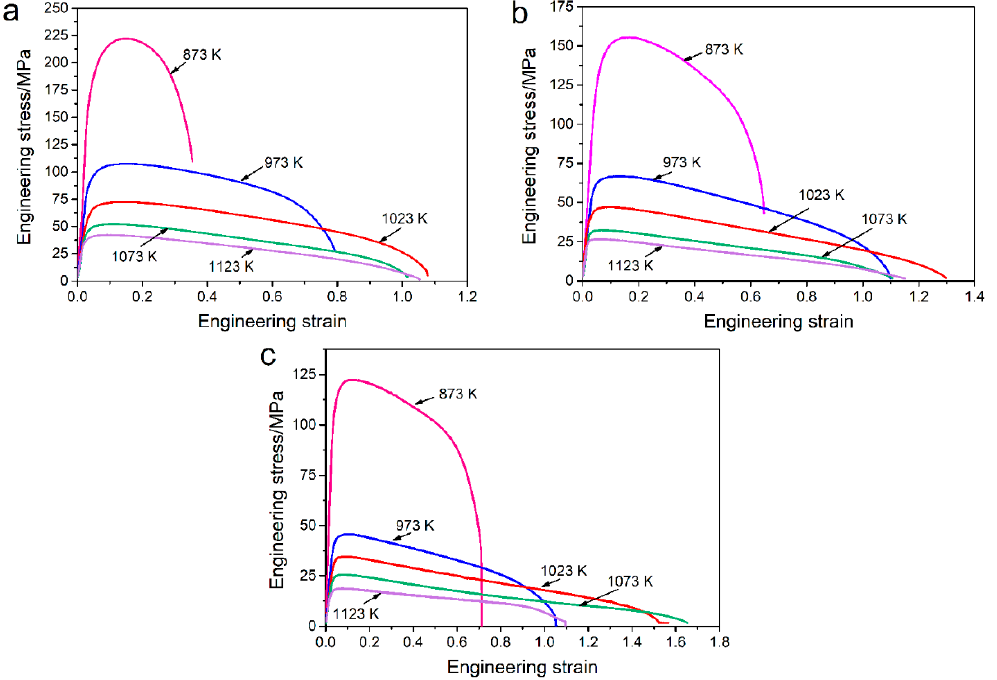
Figure 2. Tensile engineering stress–strain curves of the 0Cr18AlSi steel tested at various temperatures with strain rates of ( a ) 1.7 × 10 − 2 s − 1 ; ( b ) 1.7 × 10 − 3 s − 1 ; and ( c ) 1.7 × 10 − 4 s − 1 .